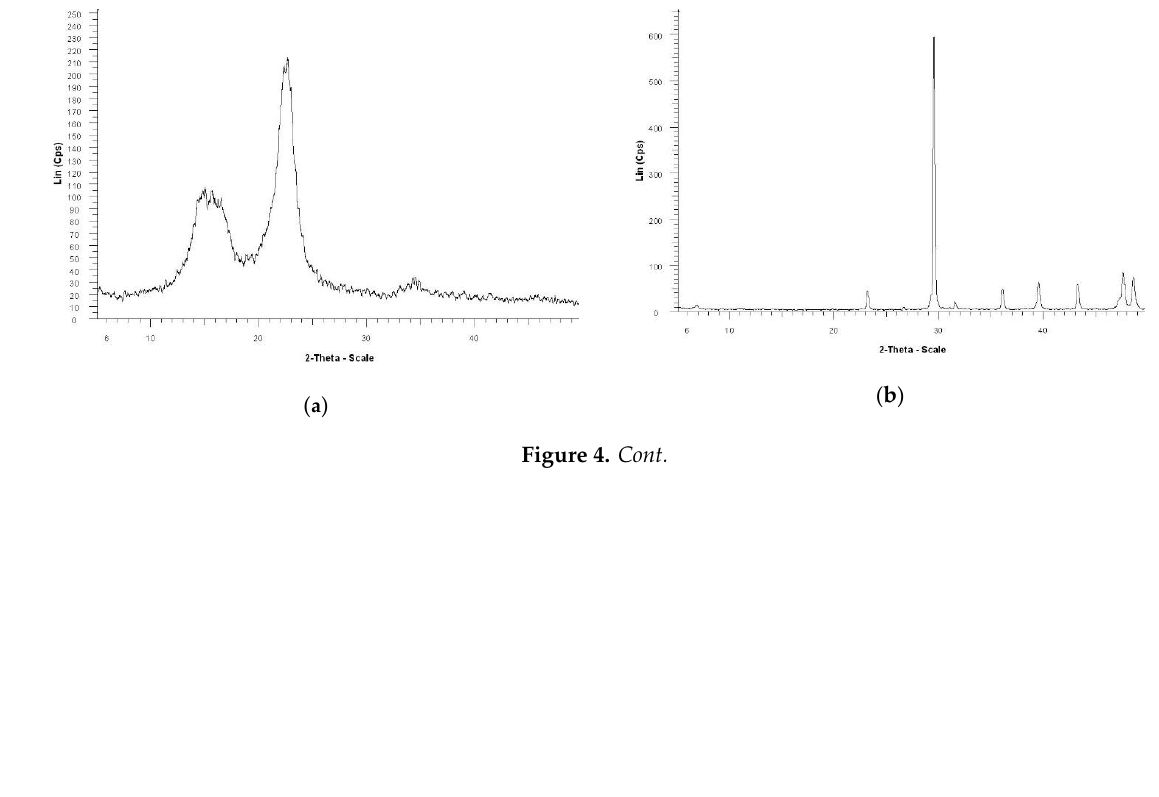
Figure 3. Particles size distribution of precipitated calcium carbonate (particle diameters and cumulative curve).